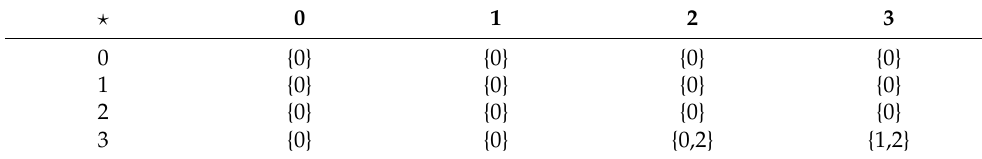
Table 5. The binary hyperoperation (cid:63) on C